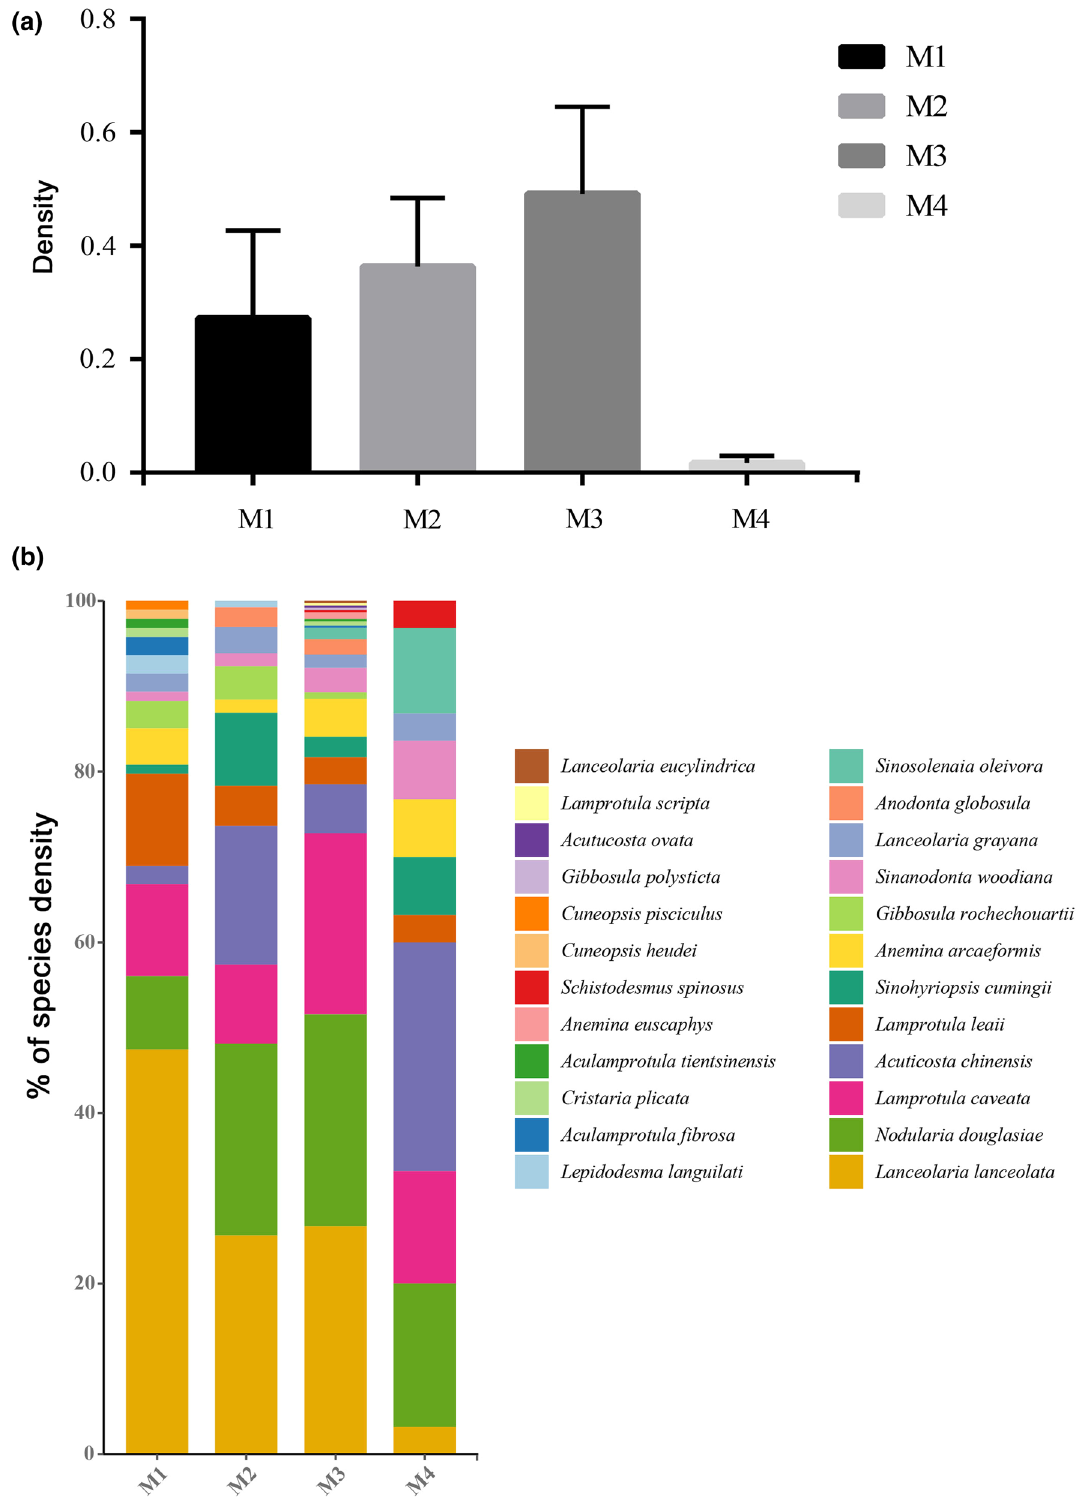
Fig. 2 Mean density of freshwater mussels ( a ) and species density ( b ) in different habitats, Poyang